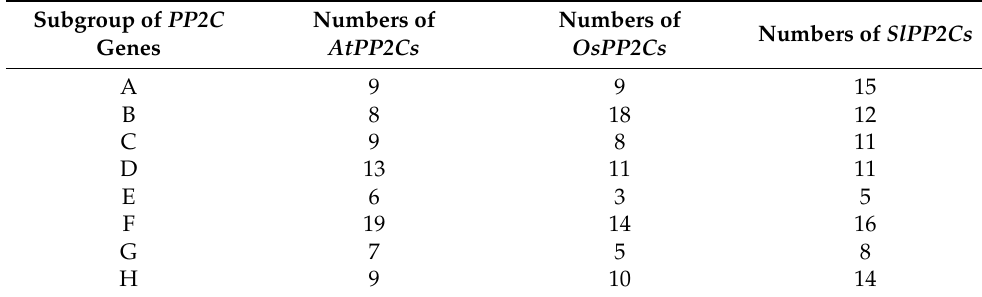
Table 2. The distribution of PP2C genes in Arabidopsis, rice, and